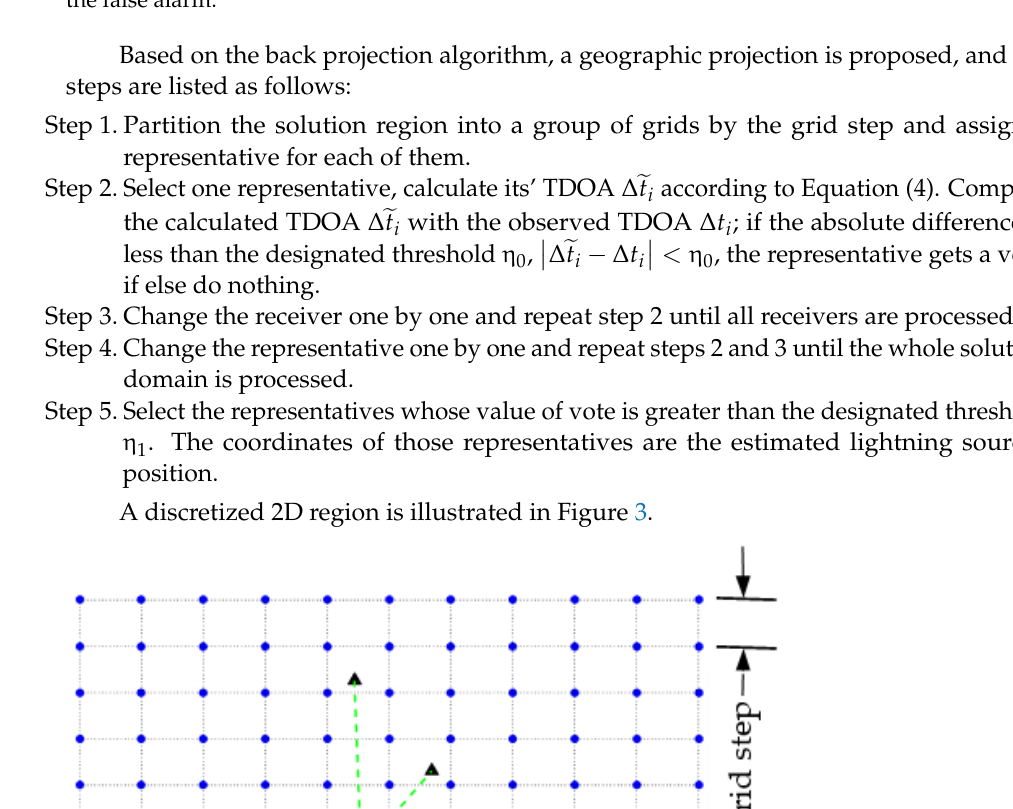
Figure 2. Illustration of the back projection algorithm. A and B are echoes of the lightning flash, F is the false alarm. the false alarm.